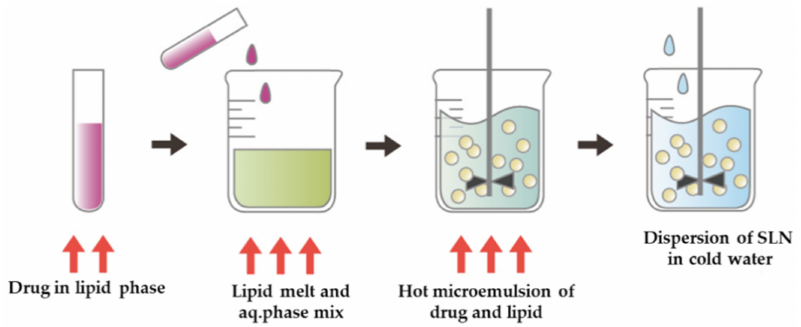
Figure 10. The procedure of microemulsion